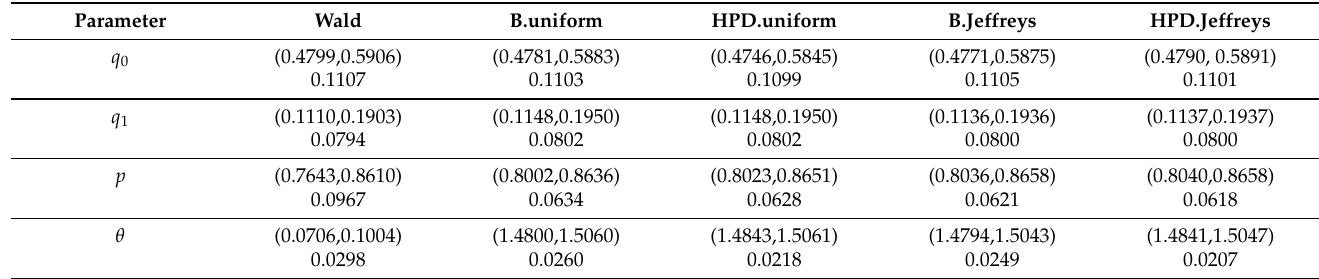
Table 6. Estimation of the number of COVID-19 daily new deaths in Luxembourg in